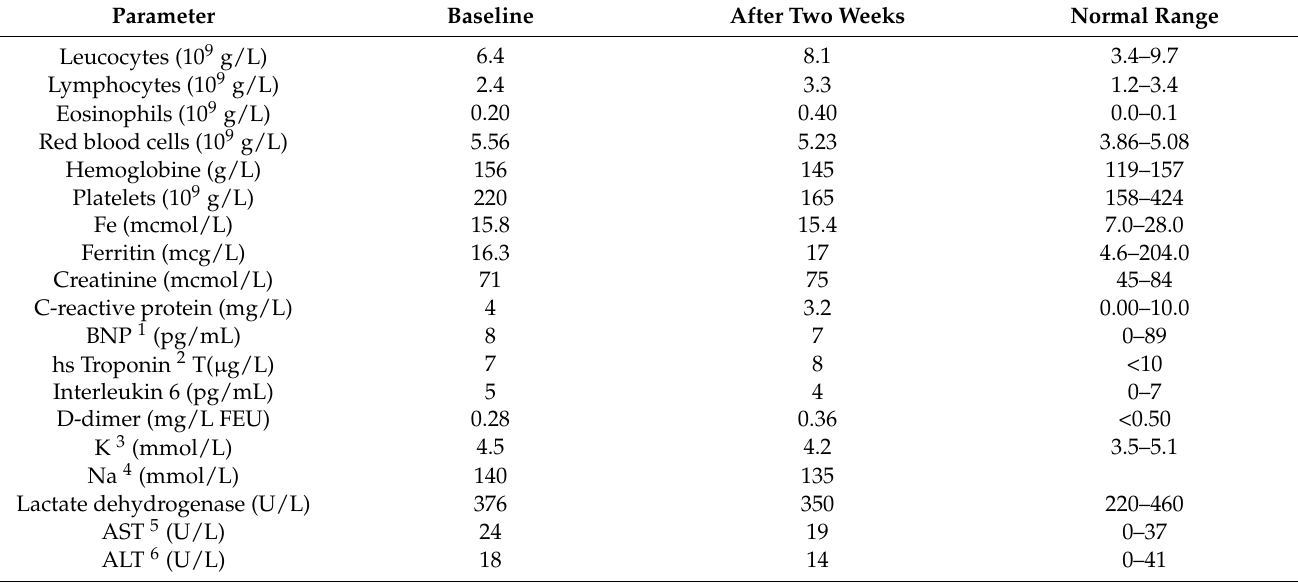
Table 1. Laboratory findings during COVID-19 infection and after a 15-day